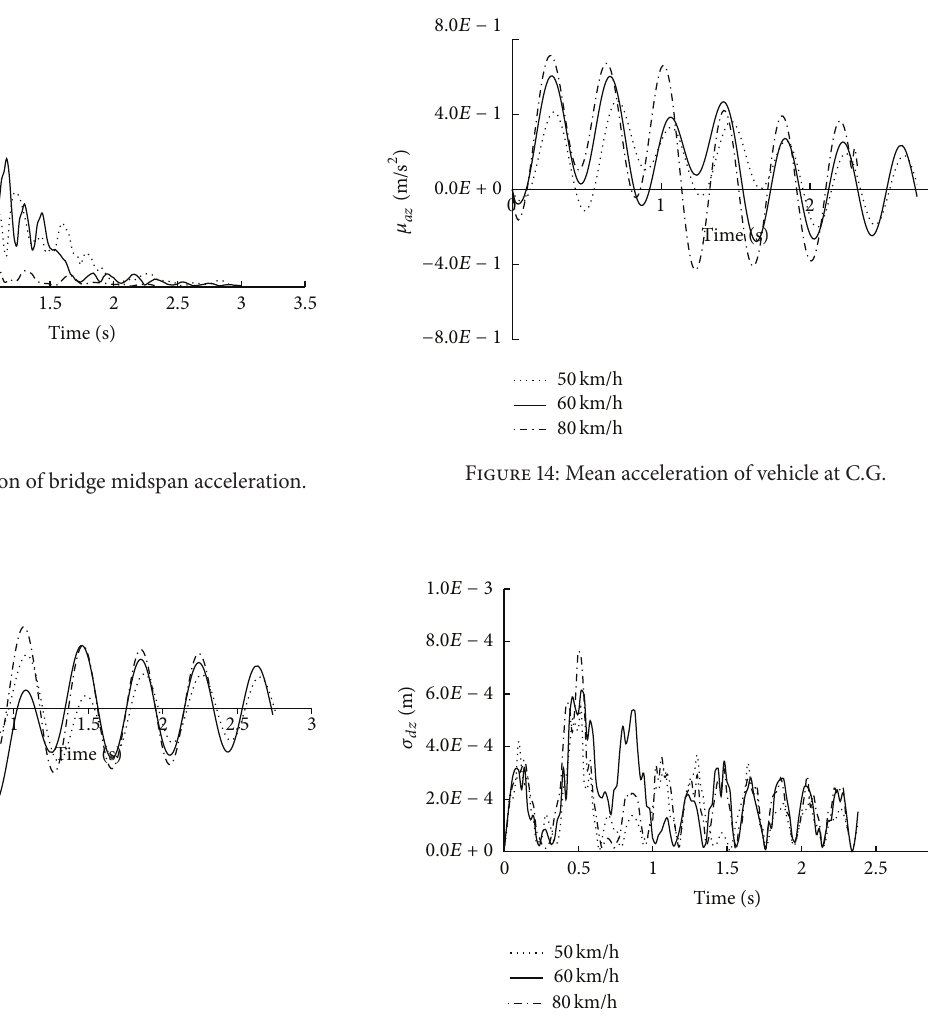
Figure 15: Standard deviation of vehicle displacement at